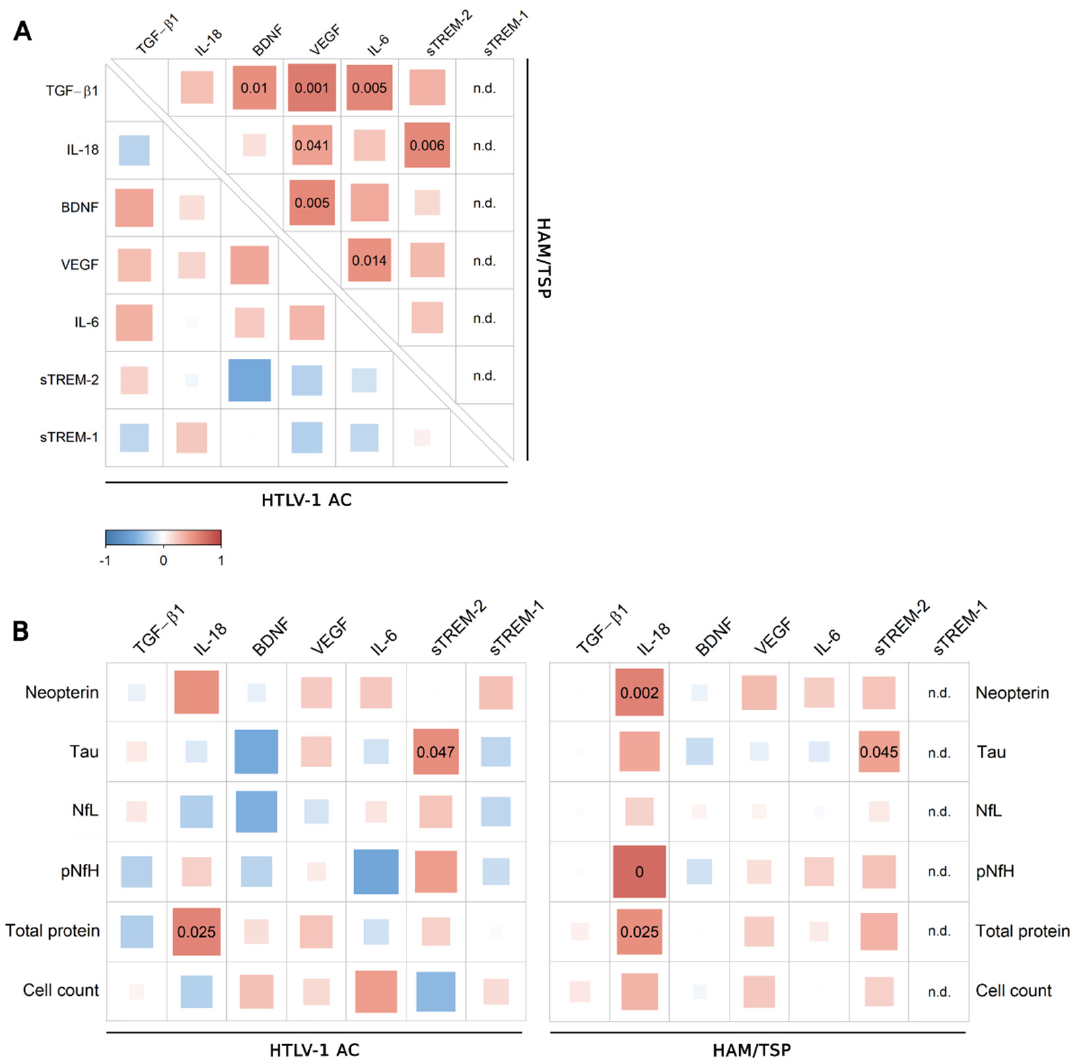
Figure 5. Correlation analysis of CSF levels of factors associated with neuroinflammation. ( A ) Correlation between CSF levels of TGF- β 1, IL-18, BDNF, VEGF, IL-6, sTREM-2, and sTREM-1 in samples from asymptomatic HTLV-1 carriers (AC) ( n = 13) and HAM/TSP patients ( n = 20) was performed with Spearman’s rank correlation test. ( B ) Correlation analysis was also performed with the CSF levels of neopterin, Tau protein, neurofilament light chain (NfL) and phosphorylated neurofilament heavy chain (pNfH) proteins, total proteins, and CSF cell counts from HTLV-1 AC and HAM/TSP patients. Correlation coefficients are indicated by color intensity, in which positive correlations are shown in red and negative correlations in blue. The size of the squares at intersections between factors represents the p -value, which is shown only for significant associations ( p < 0.05).